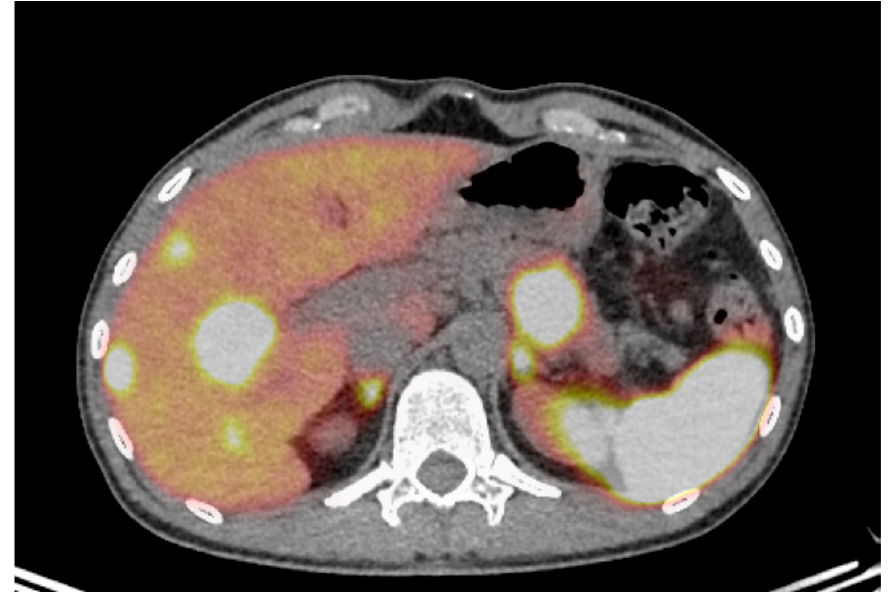
Figure 2. 68 Ga-DOTATOC transaxial fusion image in color scale of a 43-year-old patient with hepatic lesions identified as grade 2 (Ki 18%) neuroendocrine tumor. 68 Ga-DOTATOC identified a pancreatic lesion and several hepatic metastases. Given its proliferation index, the patient was treated with doublet chemotherapy with temodal and capecitabine.